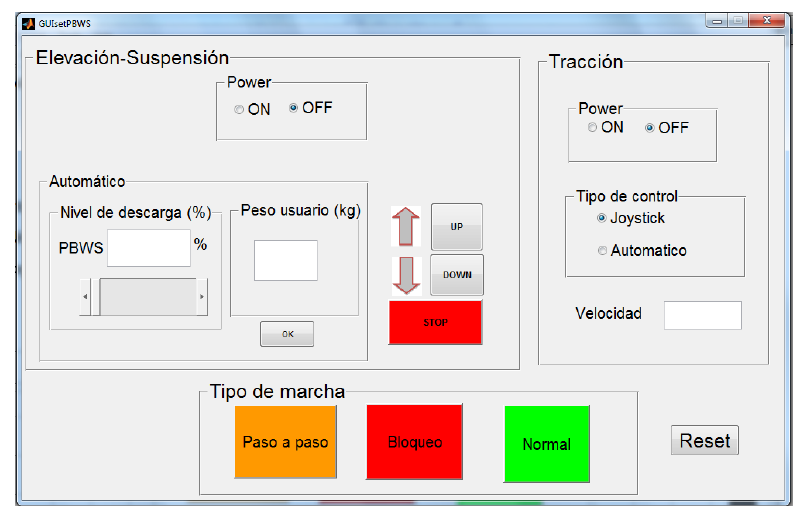
Figure 14. Therapist configuration graphical user interface (GUI).